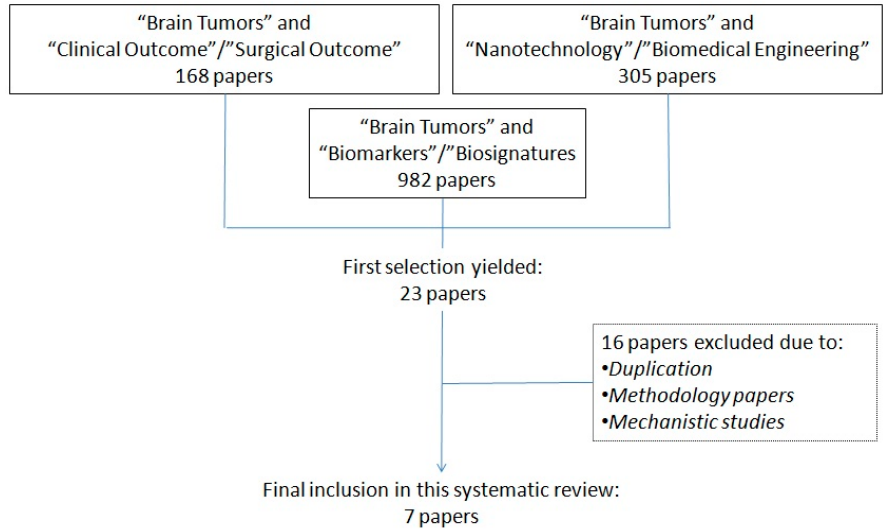
Figure 1. Selection process of suitable articles to be analyzed in this systematic review.